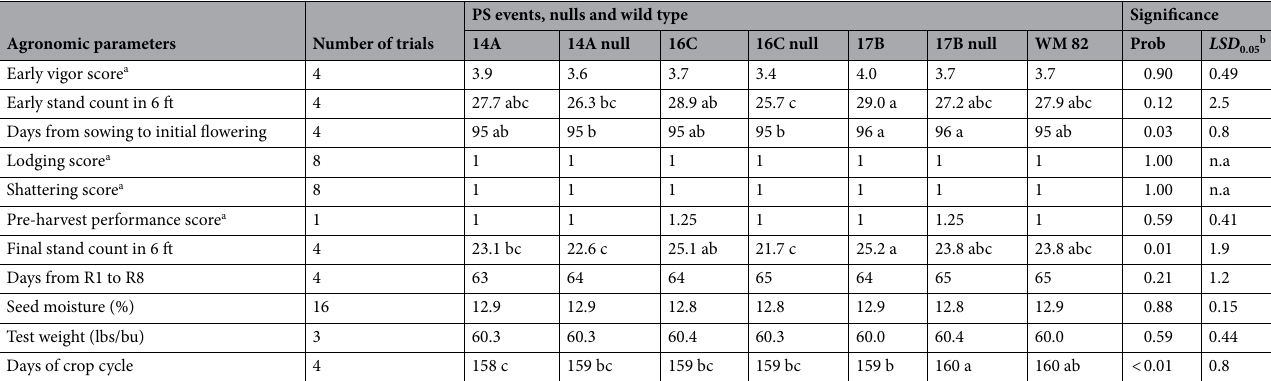
Table 1. Effects of psNTP9 gene on other agronomic attributes. Early vigor score, initial and final plant stand counts, days to initial flowering, days from R1 to R8 stages, and days of crop cycle were observed from four field trials conducted in Argentina (Ferre site A and B, Buenos Aires; Venado Tuerto site A, Santa Fe) in 2019. Lodging score, seed shattering score, and performance score were surveyed prior to harvest from eight field trials in the USA (Beatrice, Nebraska; Creston, Iowa; Macomb, Illinois; Monmouth, Illinois; Shipman, Illinois; Remington, Indiana; Tipton, Indiana; and Delphos, Ohio) in 2019. Different red letters indicate that mean values for a parameter in a given row differ from one another with a p value < 0.05. a Scale of scoring for vigor, plot performance, lodging and shattering: 1–5. 1 = best for vigor or plot performance; very minor lodging or seed shattering, respectively. 5 = worst for vigor or performance; very severe lodging or seed shattering, respectively. b According to LSD 0.05 value, means of PS events, nulls and wild type (WM82) for a single agronomic parameter (within the same row), when indicated with the same letter, are not significantly different at the level of p < 0.05.